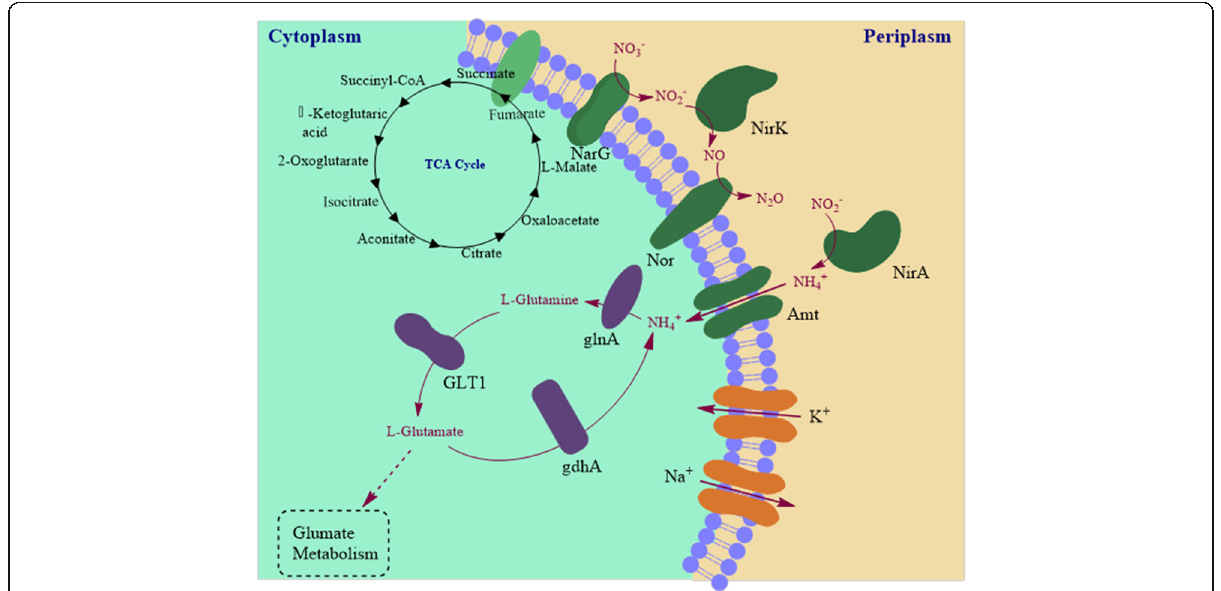
Fig. 4 Genome-based nitrogen metabolism pathways of Halomicrobium sp. ZPS1. Nitrate and nitrite could be reduced to nitrous oxide through a truncated denitrification pathway. Ammonium existing in the vegetables or formed by nitrite assimilatory could be transported into the cytochrome and transformed to L -glutamate, formed L -glutamate, which could participate in glutamate metabolism. Halomicrobium sp. ZPS1 could perform a reductive TCA cycle, and electrons generated from succinate to fumarate could be transferred to denitrification pathways. NarG, nitrite reductase; NirK, cooper-containing nitrite reductase; Nor, nitric oxide reductase; NirA, ferredoxin-nitrite reductase; Amt, ammonia channel protein; glnA, glutamine synthetase; GLT1, glutamate synthase; gdhA, glutamate